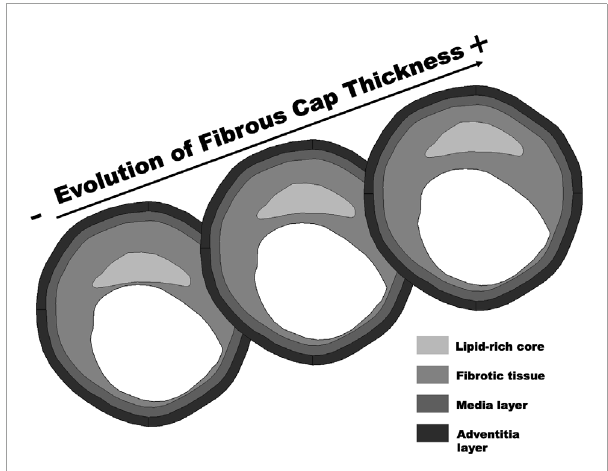
FIGURE 3 Construction of realistic database using 20 cases with varied fibrous cap thickness, based on a real geometry (65 μm –300 μm